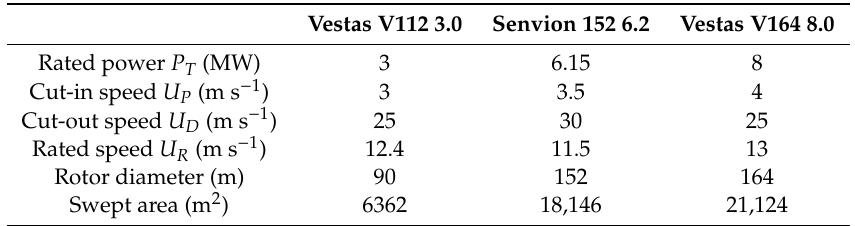
Table 1. Features of the three wind turbines selected for wind speed